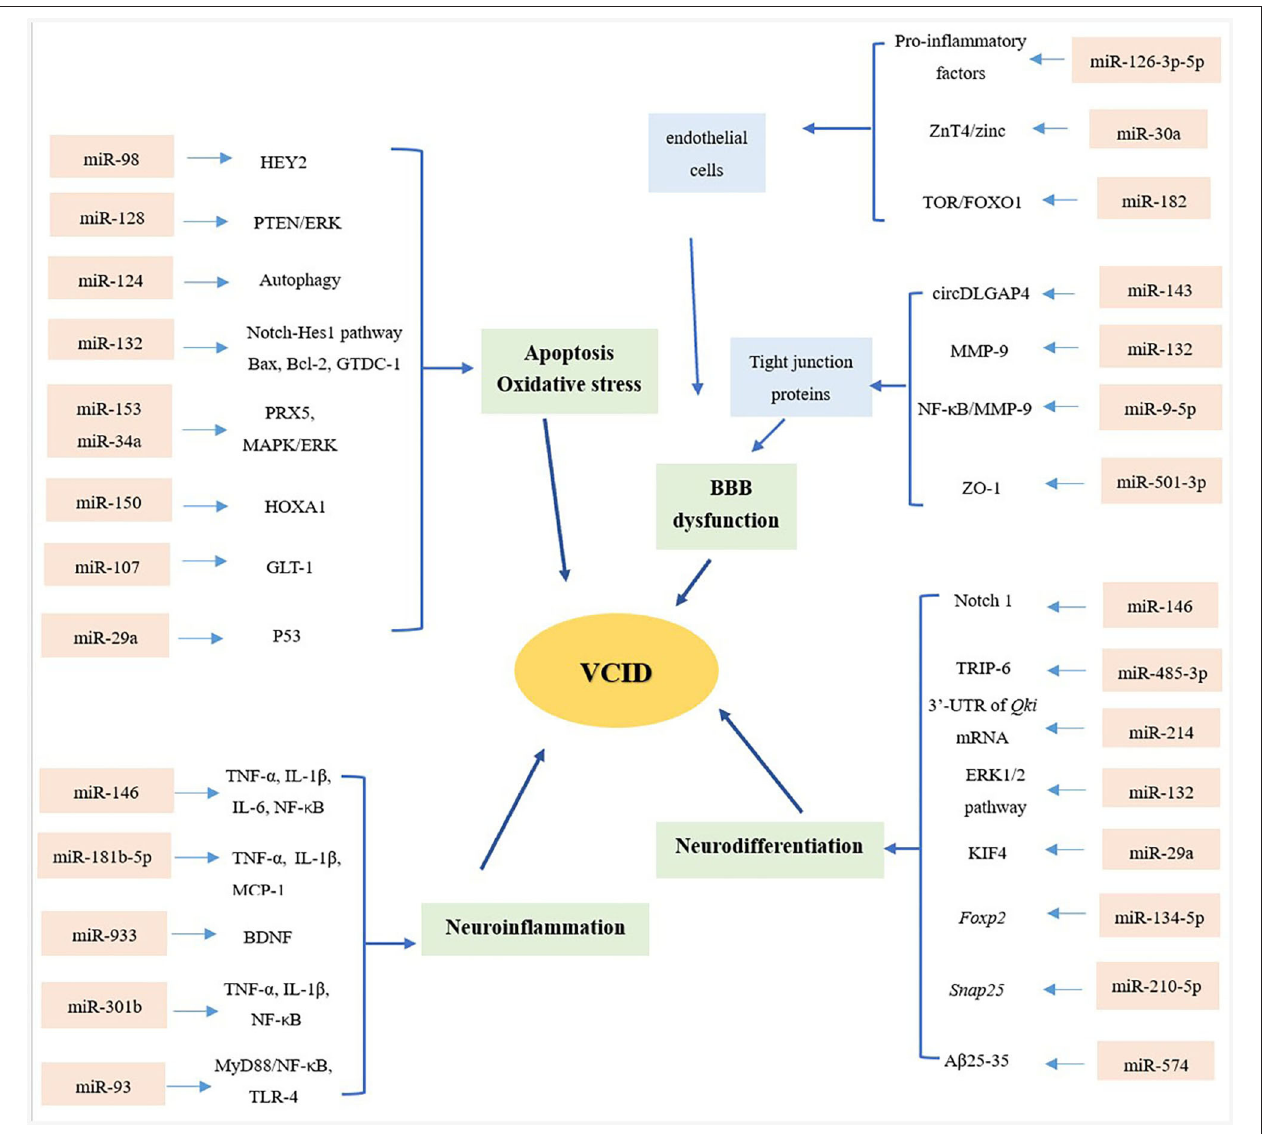
FIGURE 1 | Overview of miRNAs and mechanisms of VCID. From the aspects of blood–brain barrier (BBB) dysfunction, apoptosis and oxidative stress, neuroinflammation and neurodifferentiation, microRNAs (miRNAs) playing multiple roles in the pathology of vascular cognitive impairment and dementia (VCID), providing a novel sight and promising targets in the diagnosis and treatment of